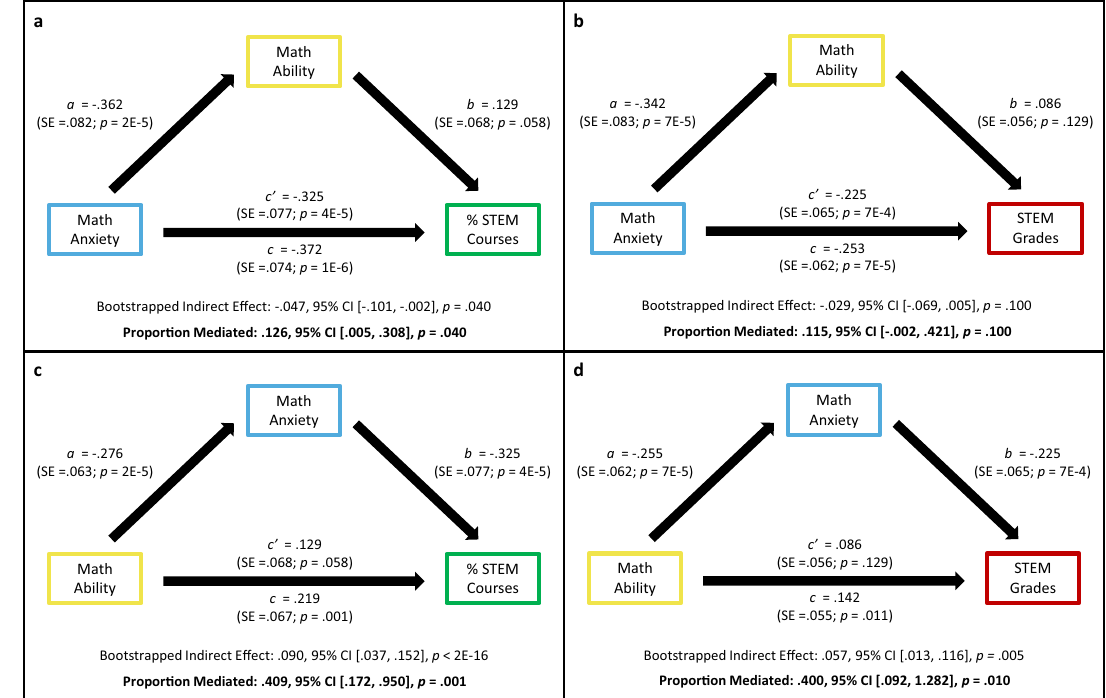
Fig. 2 Mediation models showing the extent to which predictive effects of Math Anxiety on STEM outcomes can be accounted for by Math Ability, and vice versa. Figure 2 shows mediation models that assess the extent to which Math Anxiety and Math Ability can explain each other ’ s associations with % STEM Courses and STEM Grades. The following variables were controlled for in all models: Trait Anxiety, Verbal Working Memory, Gender, non-STEM Grades, and Semesters Absent. In models where % STEM Courses was the dependent variable ( a , c ), STEM Grades was included as an additional covariate. Likewise, in models where STEM Grades was the dependent variable ( b , d ), % STEM Courses was included as an additional covariate. ‘ 95% CI ’ refers to bootstrapped 95% con fi dence